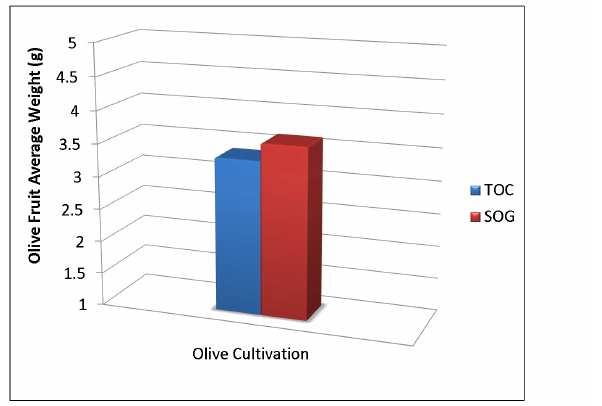
Figure 8. The average weight of the olive fruit of the proposed SOG and TOC The same steps were also applied to measure the crossed diameter. An increase in longitudinal diameter or cross diameter or both together indicates that the fruit is vigorous and was cared for during the growth